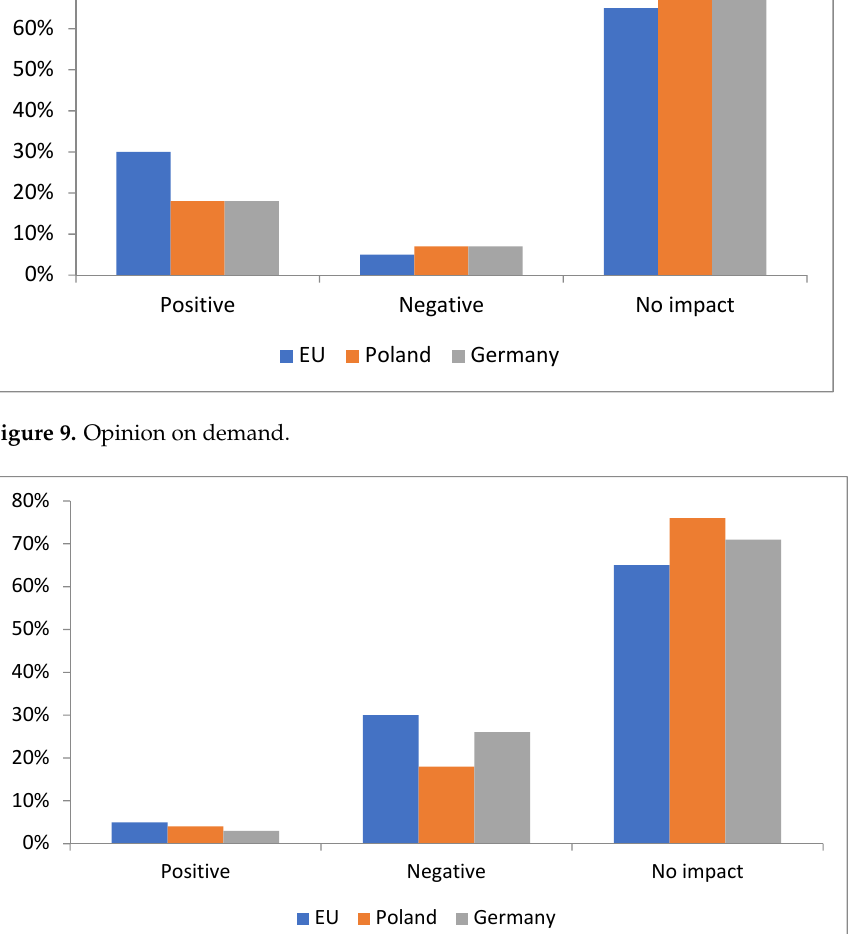
Figure 10. Opinion on the implementation of the supply chain.